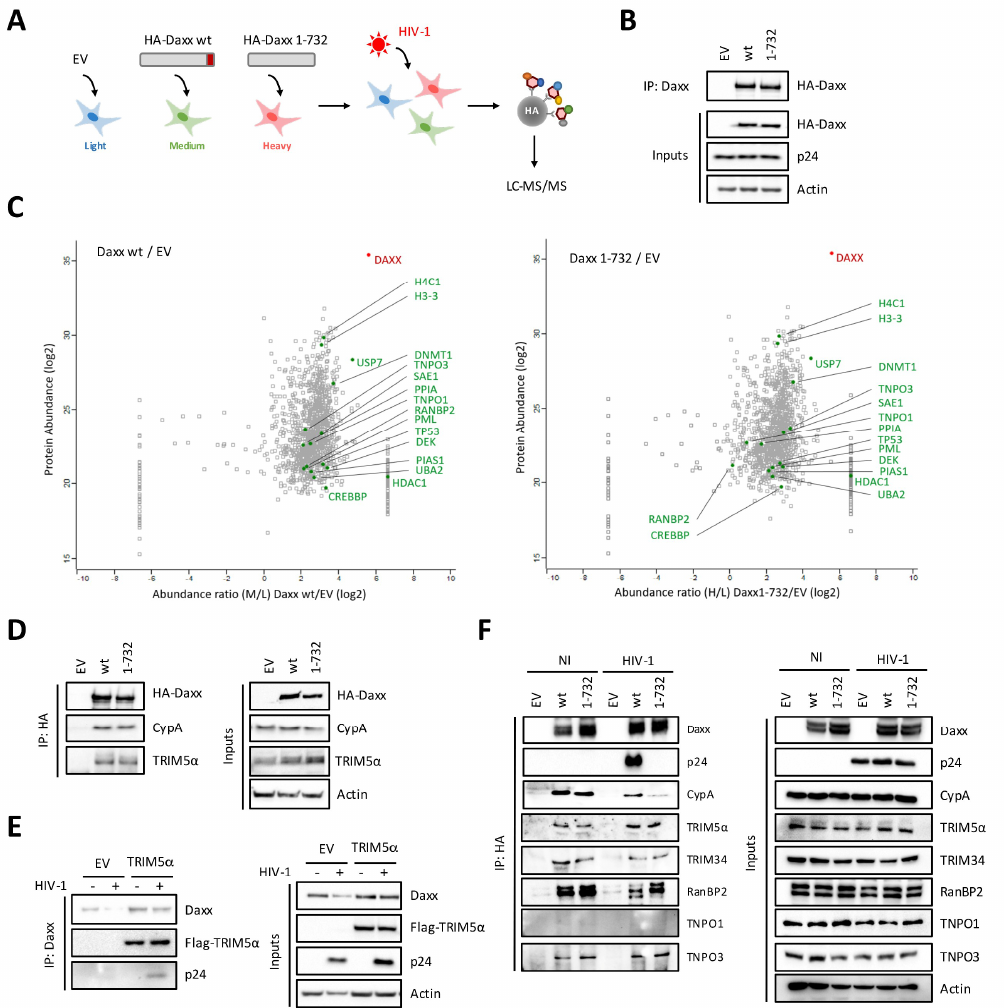
Figure 3. Identification of proteins interacting with Daxx by SILAC. ( A ) Schematic representation of the experimental procedure. HEK293T cells were cultured in medium containing light, medium, or heavy isotopes for 30 days. Then, cells were transfected with empty vector (EV) or with plasmids encoding HA-tagged Daxx wt or 1-732 ( ∆ SIM mutant). After 24 h, cells were transduced with VSV-G pseudotyped HIV-1 at a MOI of 10. At 4 h post transduction, Daxx was immunoprecipitated